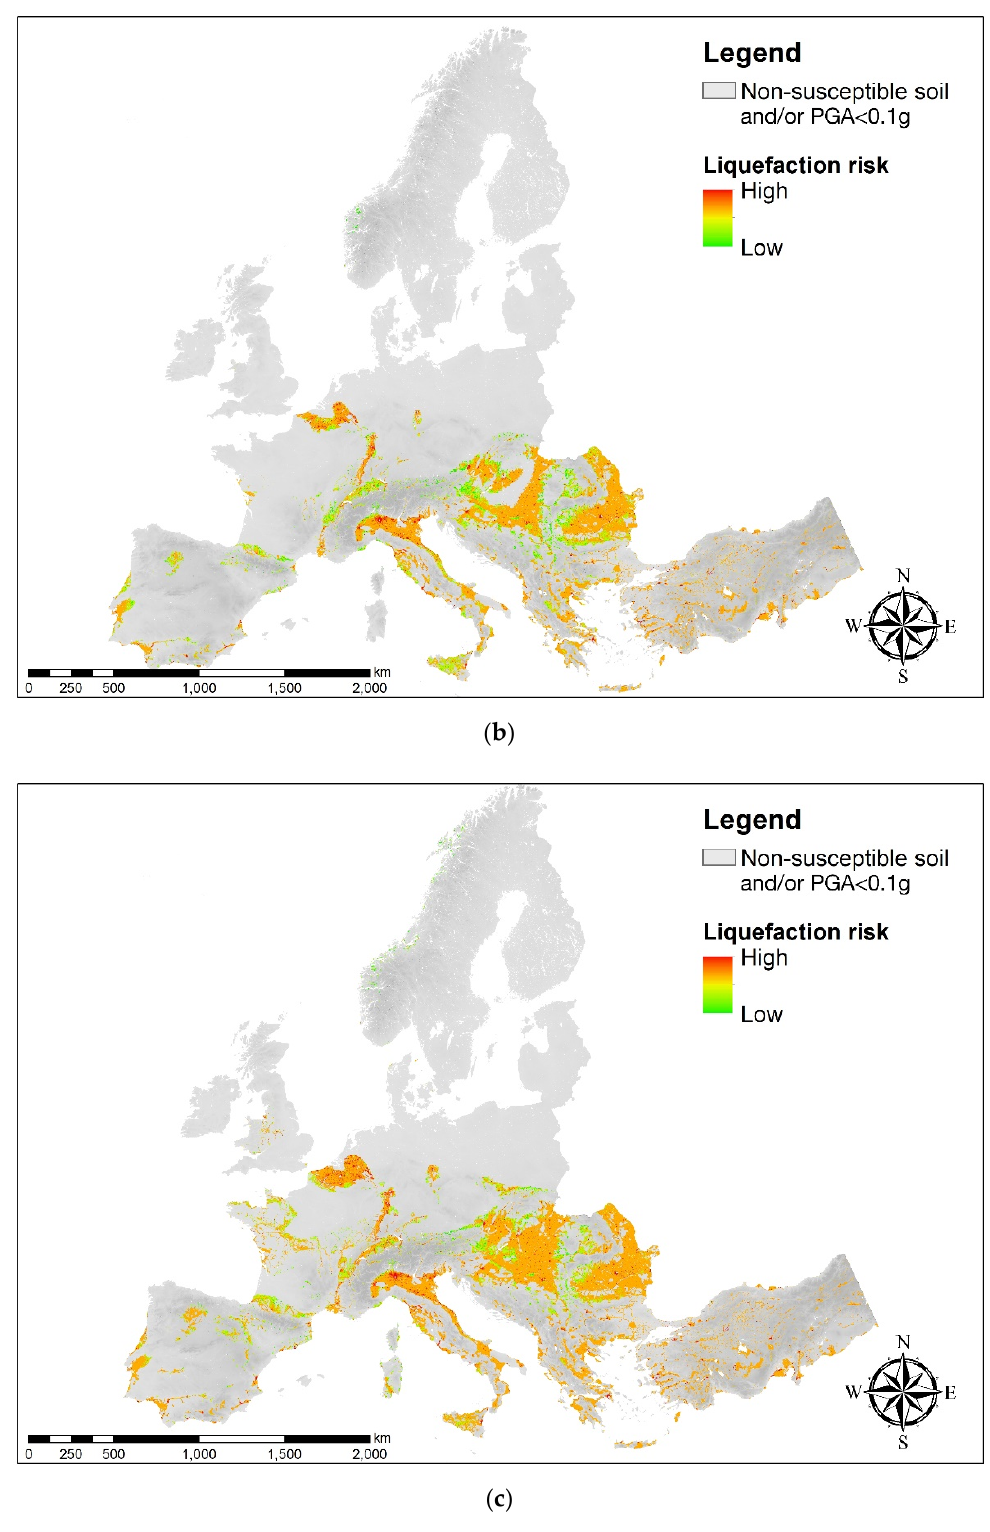
Figure 4. European liquefaction risk maps were calculated in this study for the return periods of 475 ( a ), 975 ( b ), and 2475 ( c ) years. The grey areas are a priori excluded because of the geological-based and seismic-hazard based filters applied (the greyscale is based on the DEM).